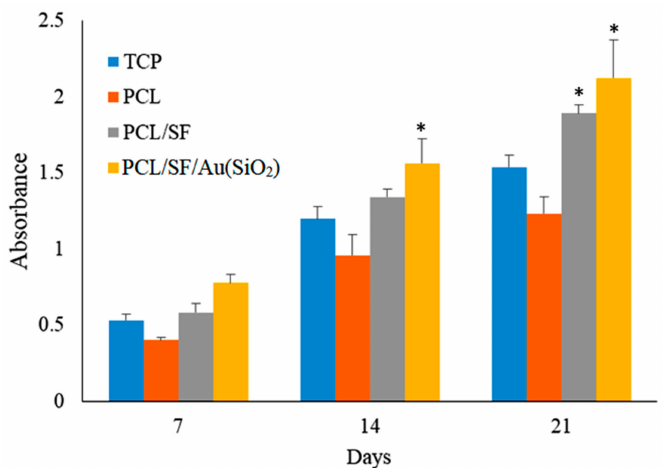
Figure 5. Cell proliferation of hMSCs on TCP, PCL, PCL / SF and PCL / SF / Au(SiO 2 ) nanofibrous sca ff olds on day 7, 14 and 21. * p <